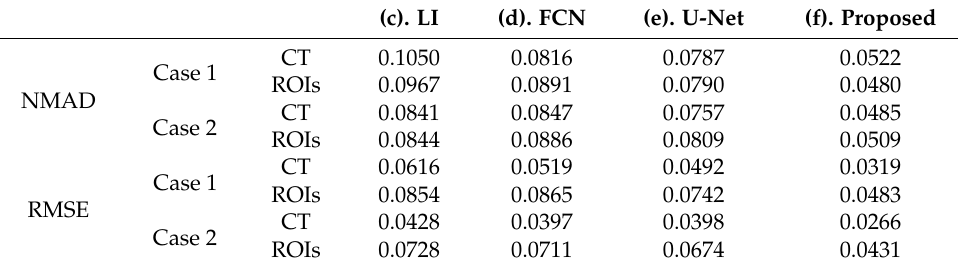
Table 4. NMAD and RMSE results of reconstructed image and ROIs of actual experiments.